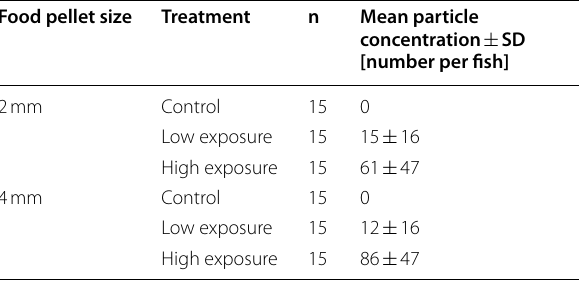
number of examined =